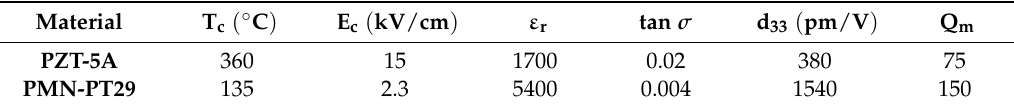
Table 1. Comparison of the parameters of PZT-5A and